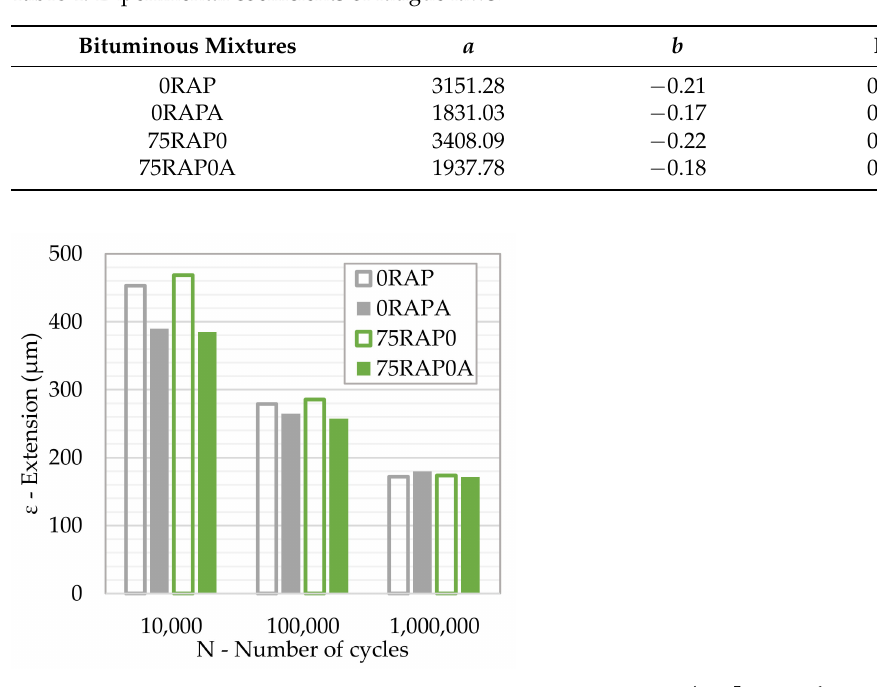
Table 4. Experimental coefficients of fatigue laws.